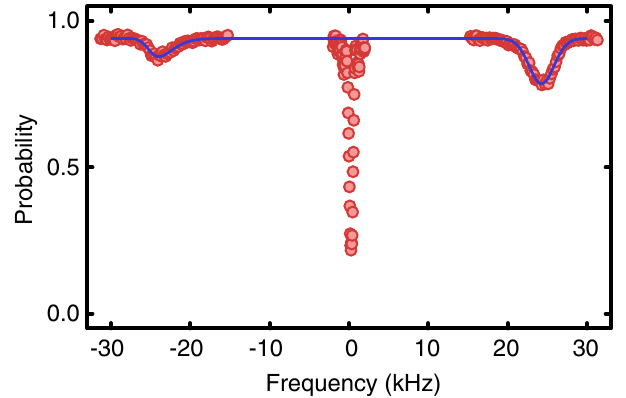
FIG. 7. Clock sideband thermometry. Array-averaged radial sideband spectrum of the optical clock transition, taken with a carrier Rabi frequency of approximately 360 Hz. A narrow carrier stands in between two broader sidebands on the red and blue detuned sides. Sideband broadening is due mainly to small inhomogeneities in the array. A suppressed red sideband indicates significant motional ground-state population. The solid line is a simultaneous fit to two skewed Gaussians. From the ratio of the area under the red sideband to that under the blue sideband, we obtain ¯ n ≈ 0 . 66 . The carrier is probed for an interrogation time of 1.4 ms, while the sidebands are probed for 3.3